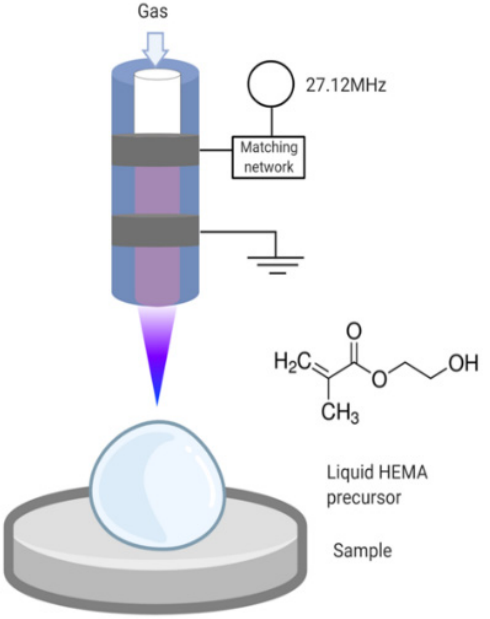
Figure 1. Schematics of the atmospheric pressure plasma jet used in this study, employing Ar as a working gas to polymerize the liquid 2-hydroxyethyl methacrylate (HEMA) monomer on titanium samples or silicon wafers.